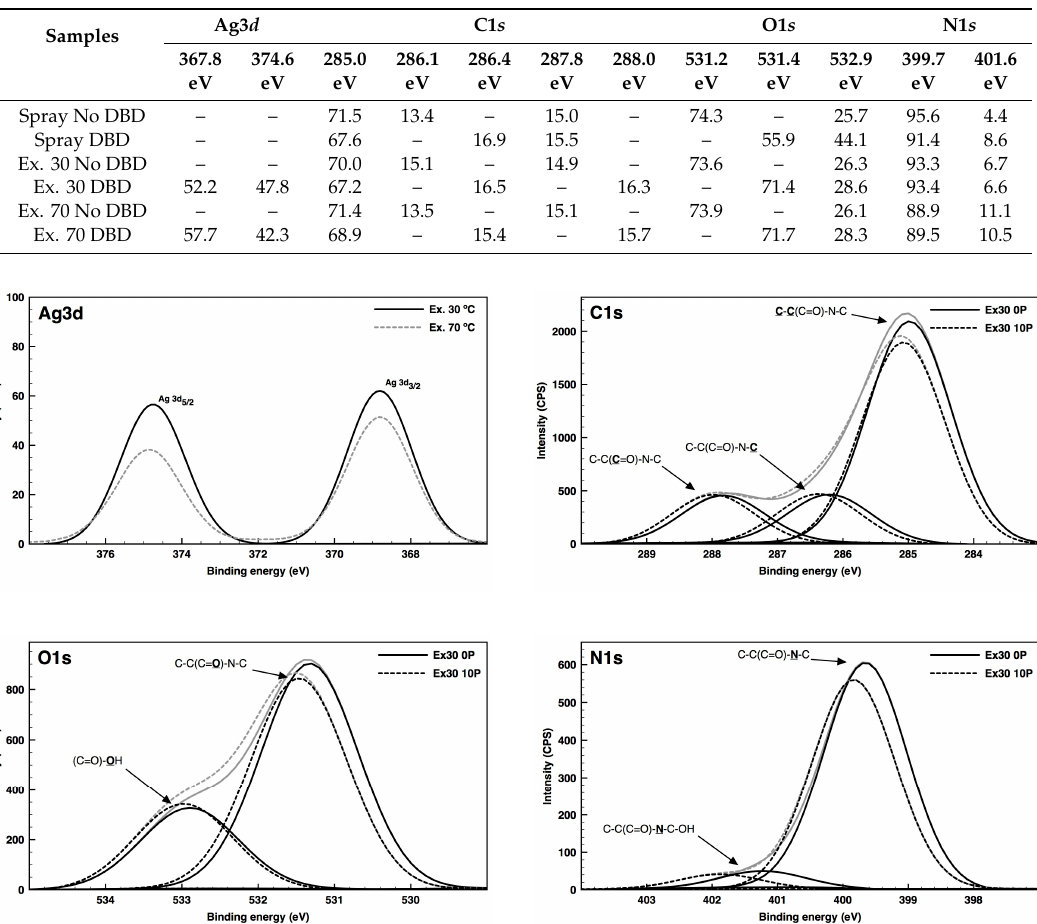
Figure 5. High-resolution deconvoluted XPS spectra with relative areas of the Ag3 d , C1 s , O1 s and N1 s binding energy regions of untreated and plasma-treated PA66 fibers surface with AgNPs deposited with the exhaustion method at 30 ◦